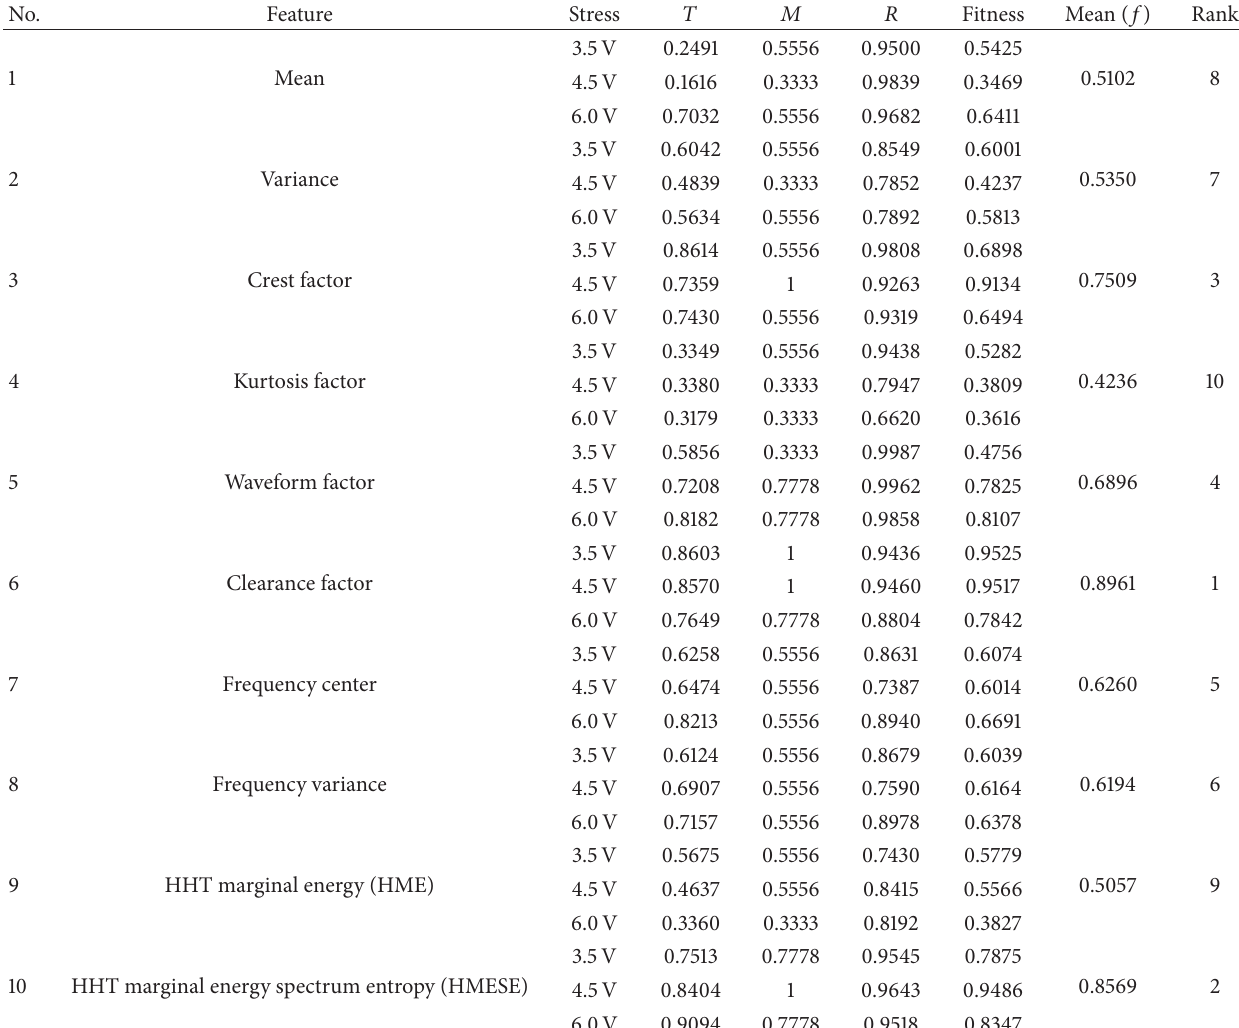
Table 3: Feature evaluation results.